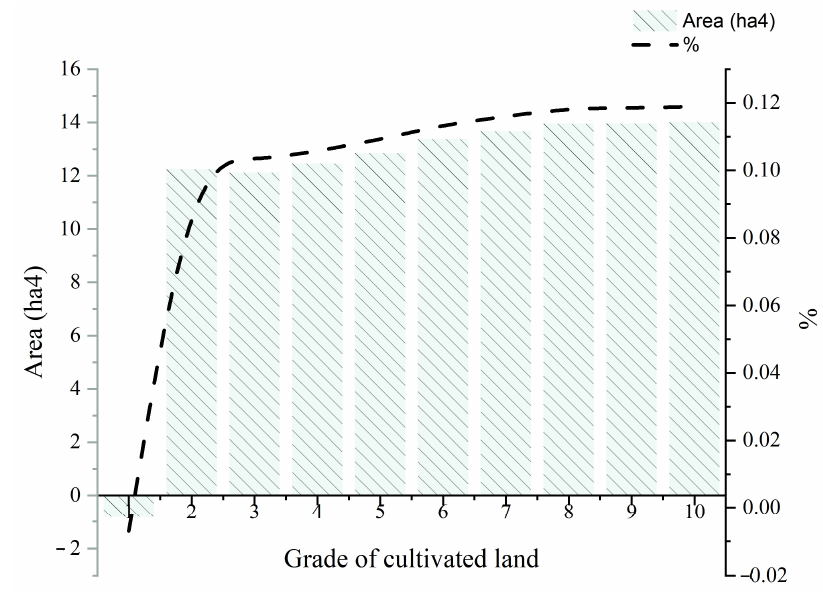
Figure 8. Status of cultivated land expansion in Northeast China.